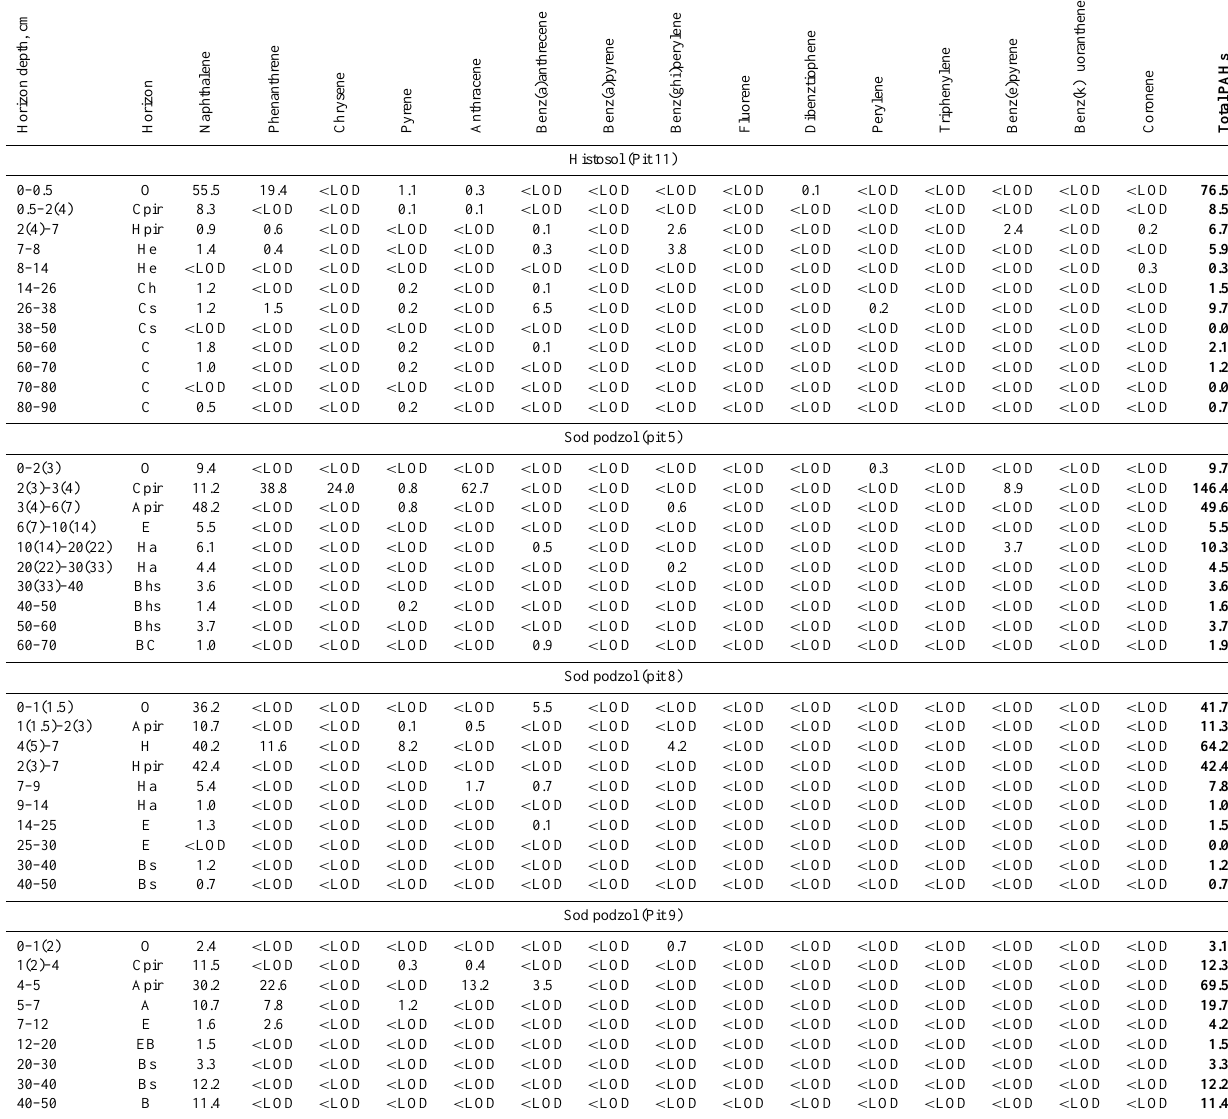
Table 3. PAH concentrations (ngg − 1 ) in post-fire soils.